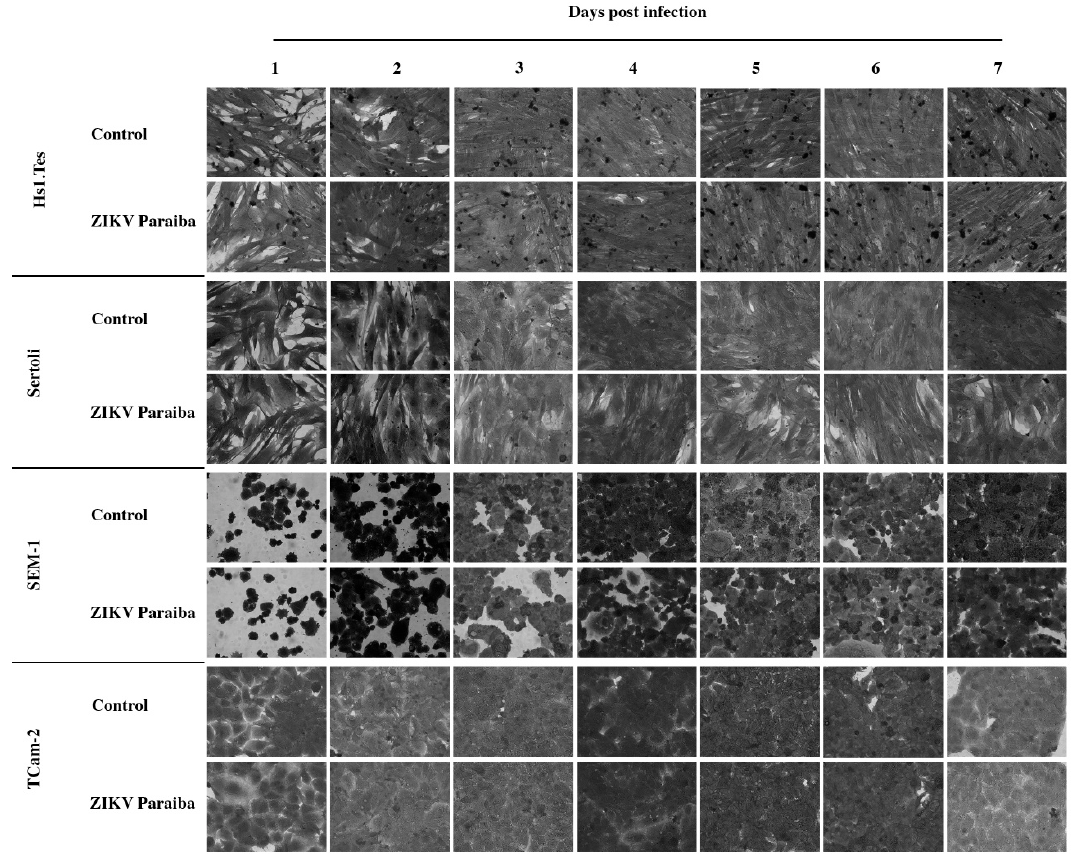
Figure 2. Microscopic evaluation of testicular cell lines infected with ZIKV Paraiba. No obvious cytopathic effect was observed in all testicular cell lines infected with ZIKV Paraiba. Images were captured at a magnification of 400×.